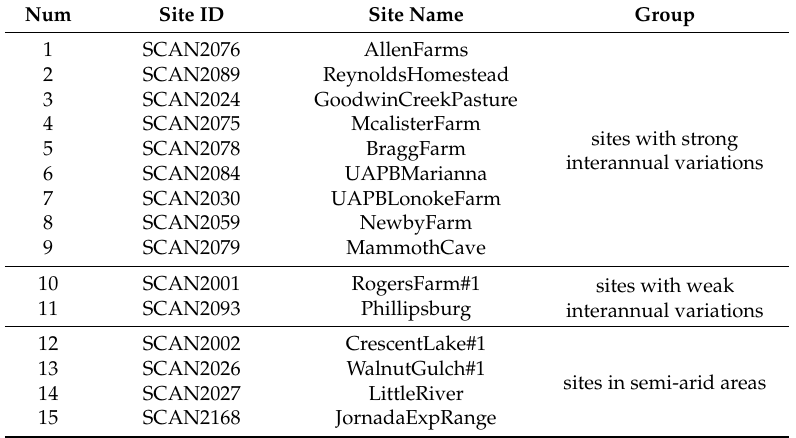
Table 1. Characteristic descriptions of the selected Soil Climate Analysis Network (SCAN)